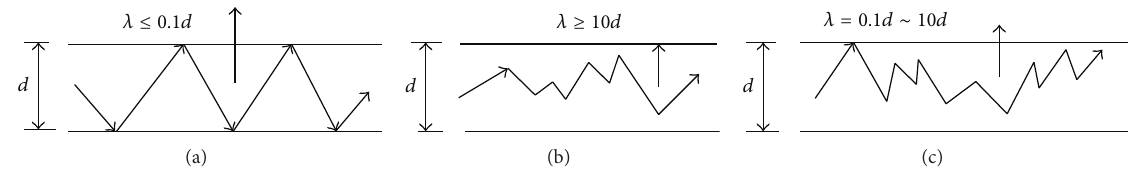
Figure 4: Diffusion mechanisms: (a) Knudsen, (b) Fickian, and (c) Transition.